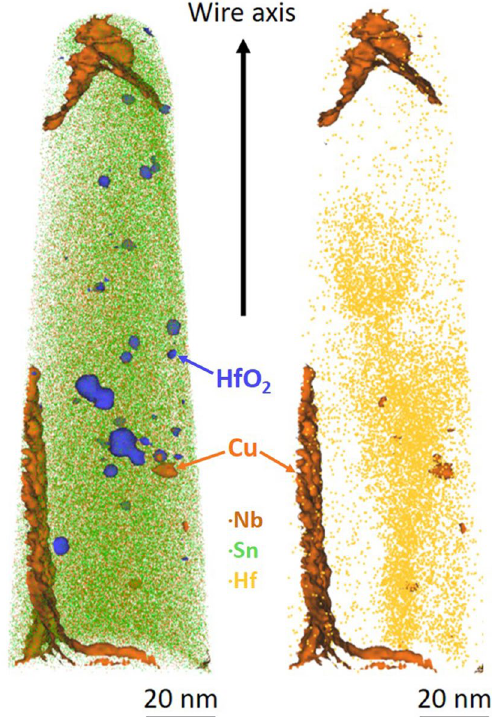
Figure 5. Atom Probe Tomography of Ta-Hf-doped Nb 3 Sn sample. Atom Probe Tomography of a needle- shaped sample (tip at the top of the figure) extracted by FIB from the A15 layer of the Ta-Hf doped Nb 3 Sn wire. The 4 at% copper iso-concentration surfaces in orange, identify the grain boundaries (and a few nanoparticles in the A15 grains). The blue iso-surfaces at 1.5 ionic% of HfO molecular species, in the left-hand image, identify the HfO nanoparticles; brown and green dots are Nb and Sn, respectively. In the right-hand image, the un-oxidized Hf species are represented by yellow